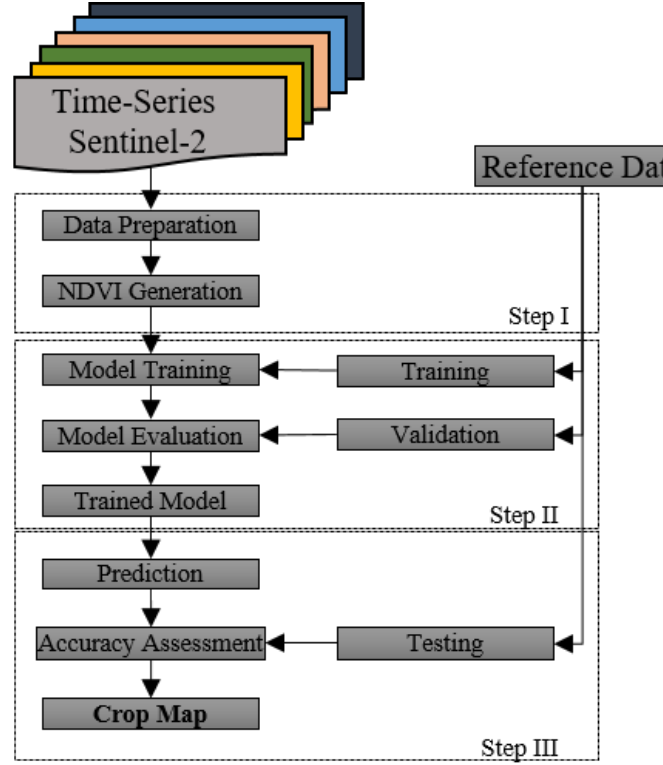
Figure 3. Overview of the proposed framework for crop mapping.